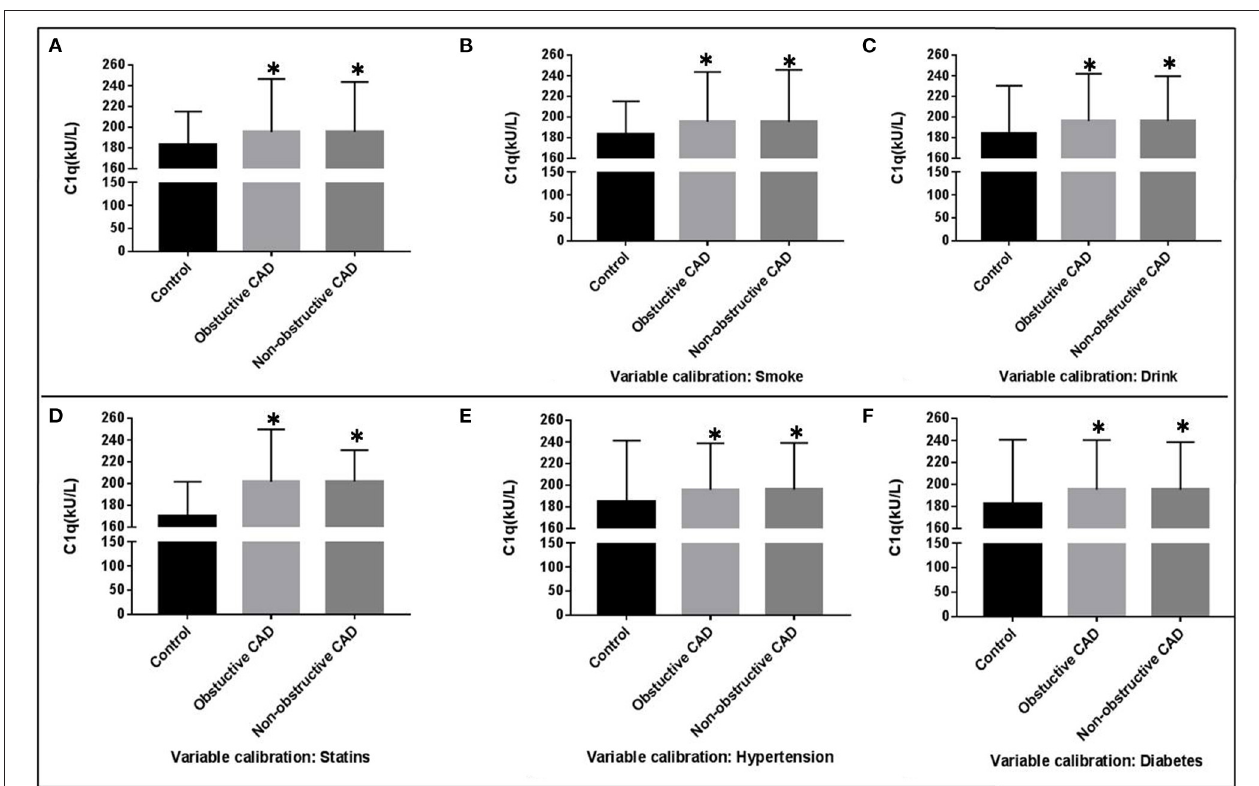
FIGURE 1 | Covariance analysis of C1q activity among the three groups. * P <